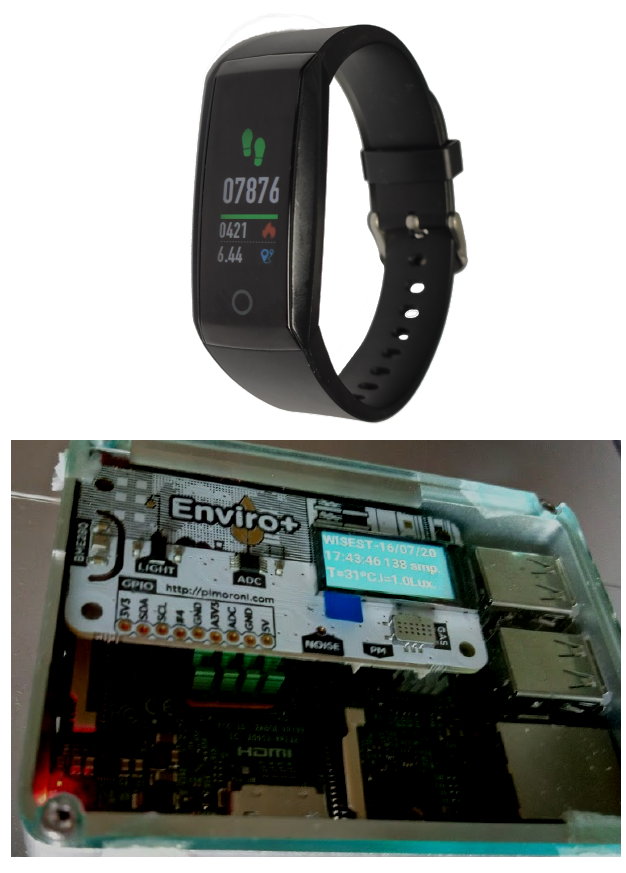
Figure 1. Some devices implemented in the case study 1. Smartbands to collect stress levels on top subfigure and Single Board Computers with appropriate plugin sensors on bottom subfigure.